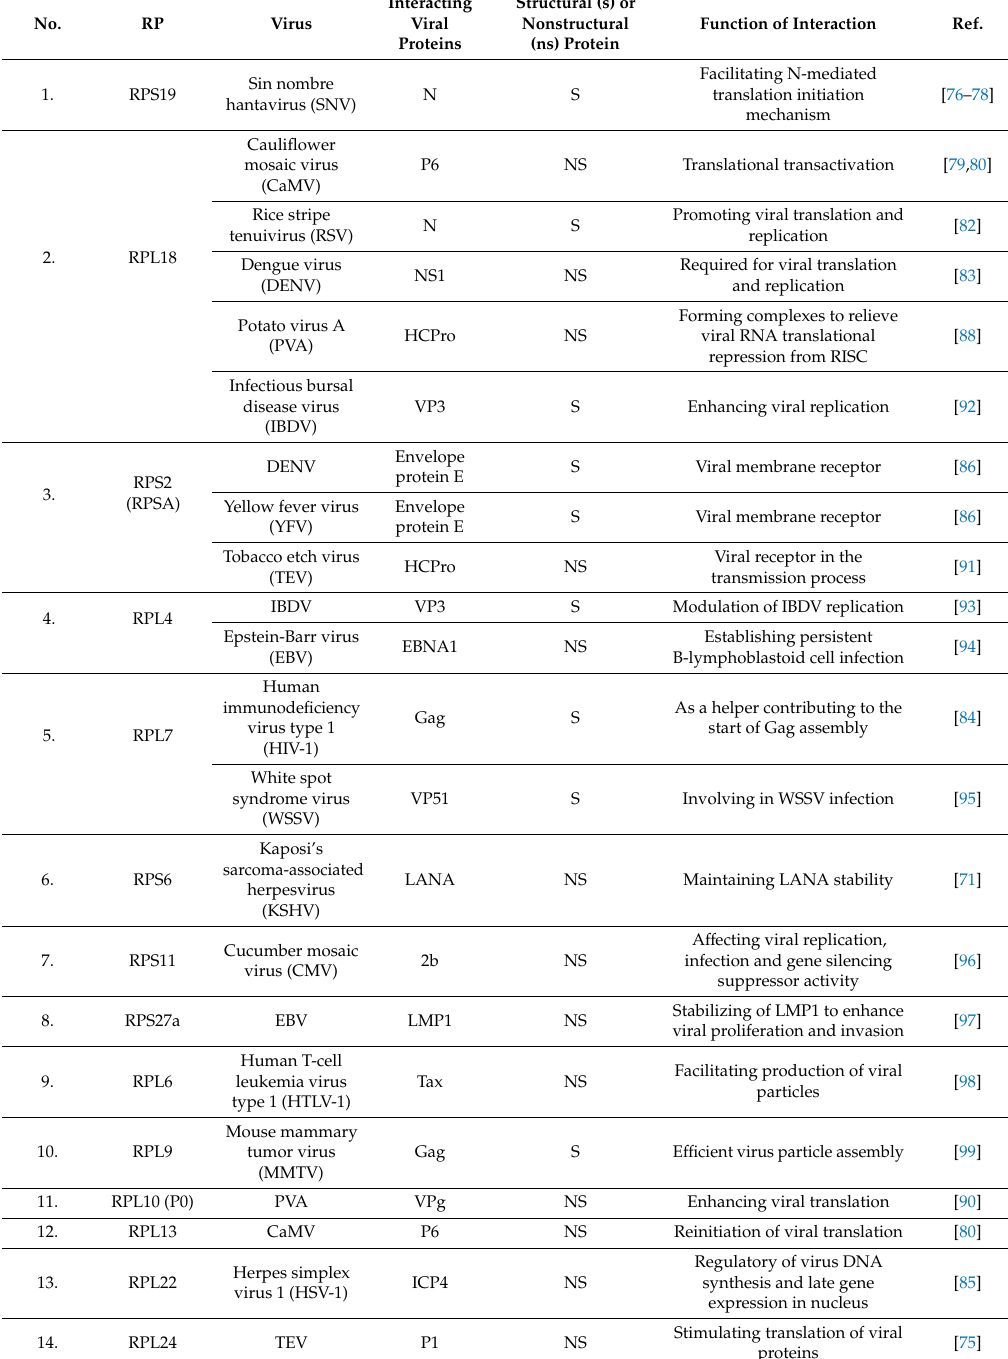
Table 1. The characterized roles of the interactions between RPs and viral proteins on positive regulating viral